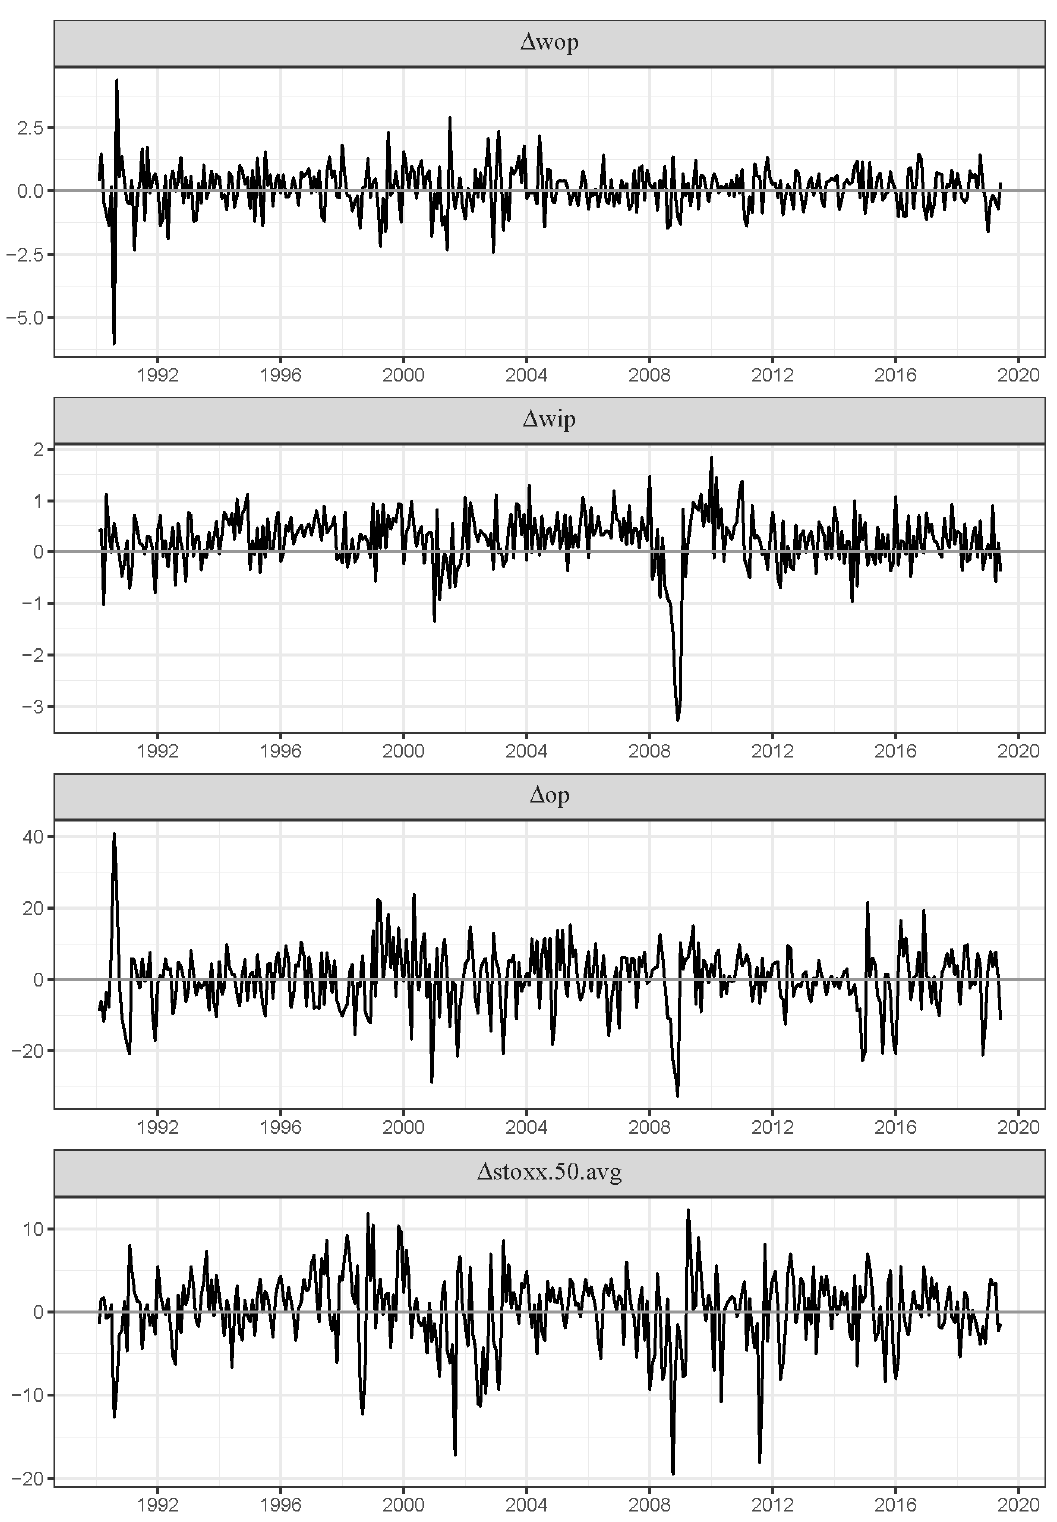
Figure 1. Evolution of returns. Note : This figure shows the evolution of returns on world oil production, world industrial production, oil prices and the Euro STOXX 50 stock market index, respectively.